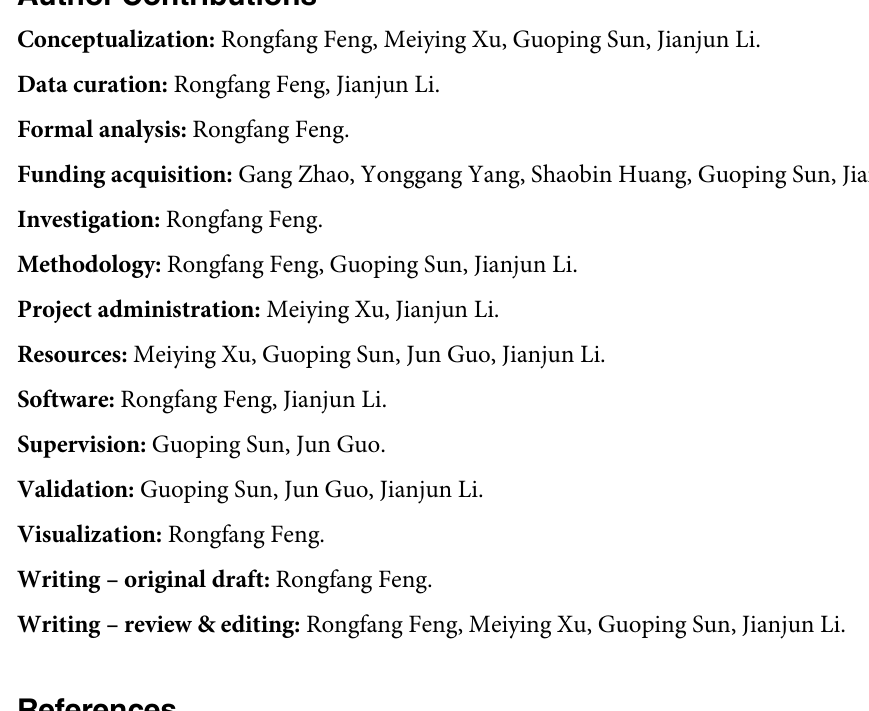
S2 Fig. Histogram of differentially abundant features between the two BTFs (logarithmic LDA score > 4.0 and p < 0.05). S1 Table. Concentrations of NO , NO , PO 43 - , CO 32 - and TOC in nutrient solution during 3 - 2 - the first 31 days. S2 Table. Pearson’ linear correlations between biofilm formation capacity and EPS with removal efficiency of the five pollutants. S3 Table. Microbial α -diversity metrics at different BTFs and time. S4 Table. Relative abundances of dominant phyla during the operating time in the two